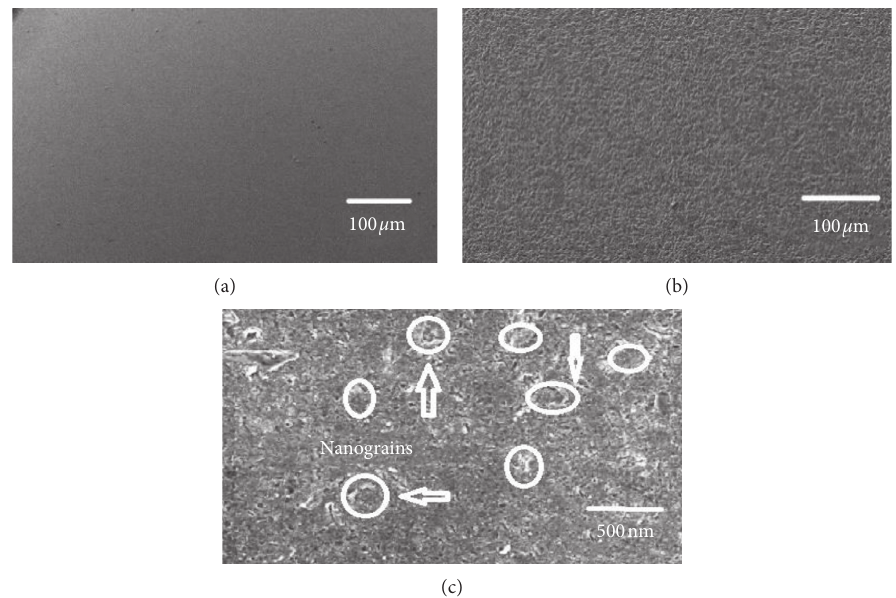
Figure 5: SEM micrographs of 6351 Al alloy (a) as extruded, (b) attrition treated for 240 minutes, and (c) attrition treated for 240 minutes at higher